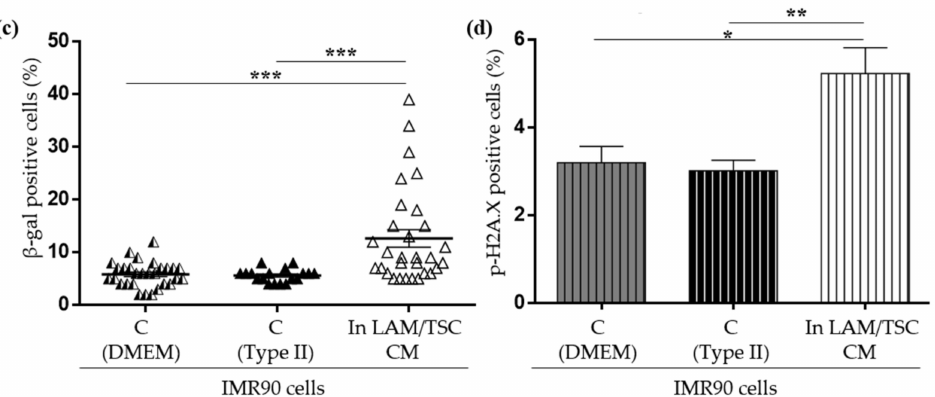
Figure 5. Senescence effect of LAM/TSC cell CM on PLFs and IMR90 cells. ( a ) Representative images of SA- β -Galactosidase staining of PLFs grown in their own CM (C, left ) and in LAM/TSC cell CM ( right ) are shown. The arrows indicate the senescent cells (blue cells). Scale bar: 100 µ m. The dot plot represents the % of β galactosidase positive cells evaluated in 10 images of 3 independent experiments. Results are shown as mean ± SEM ( n = 3). Student’s t -Test, *** p < 0.001. ( b ) Flow cytometry analysis of phospho-histone H2A.X positive PLFs cells grown in their own CM (C) and in LAM/TSC cell CM are expressed as percentage of the total number of cells. Results are shown as mean ± SEM ( n = 3). Student’s t -Test, * p < 0.05. ( c ) The dot plot shows the percentage of SA β -galactosidase